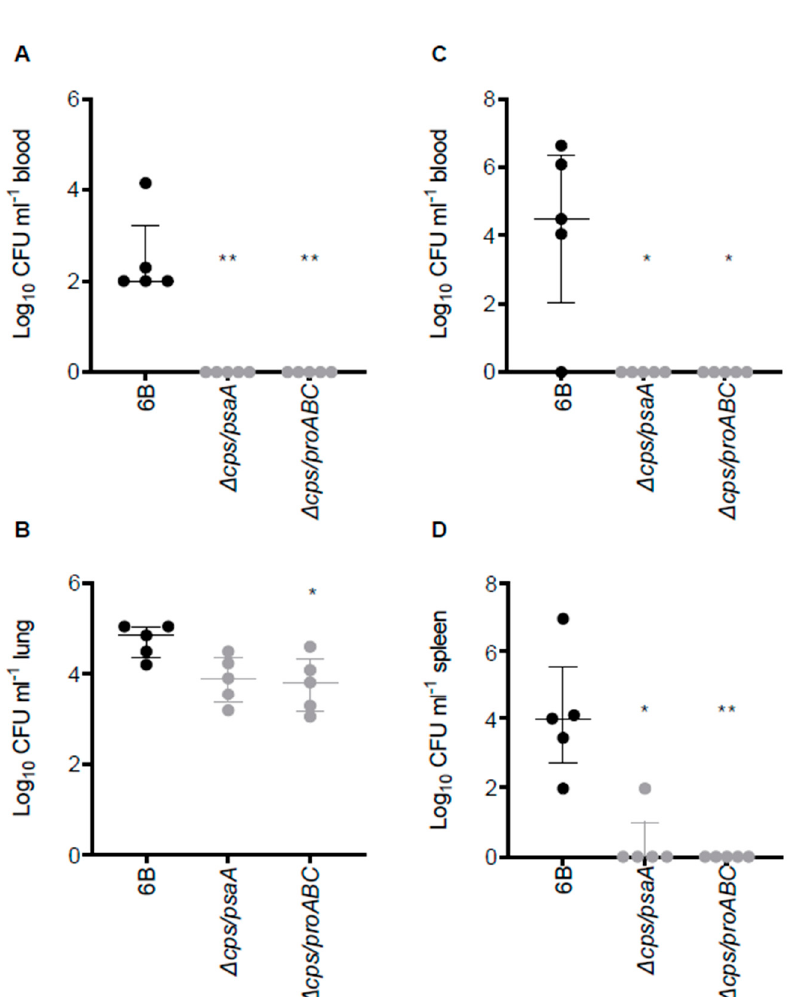
Figure 2. Virulence of double unencapsulated mutant strains in murine pneumonia and sepsis models. ( A , B ) Pneumonia model; CFU obtained from blood ( A ) and lung ( B ) of CD1 mice 28 h post intranasal inoculation with 1 × 10 7 CFU of wild type 6B or double mutant S. pneumoniae strains. ( C ) and ( D ) Sepsis model; CFU in blood ( C ) or spleen ( D ) of CD1 mice 24 h post intraperitoneal inoculation with 5 × 10 6 CFU of wild type 6B or double mutant S. pneumoniae strains. Each symbol represents CFU data from a single mouse (black symbols, wild type S. pneumoniae infection, grey mutant S. pneumoniae strain infection), horizontal bars represent median values, error bars represent interquartile range and asterisks represent statistical significance compared to the wild type strain (Kruskal–Wallis with Dunn’s post hoc test to identify significant differences between groups, * p < 0.05; ** p < 0.01).